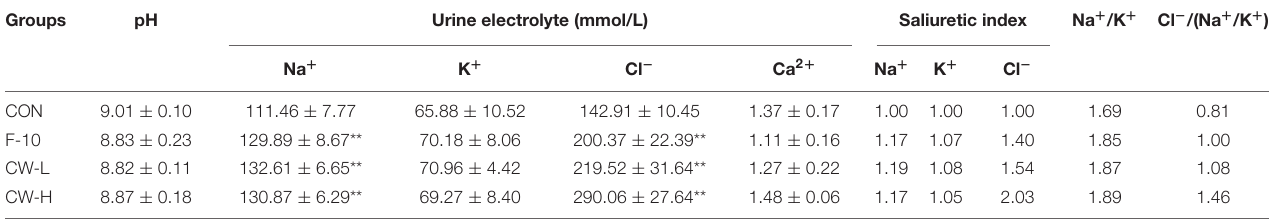
TABLE 4 | Effects of acute treatment with coconut water on the urine pH values and electrolyte concentrations of rats (24 h).